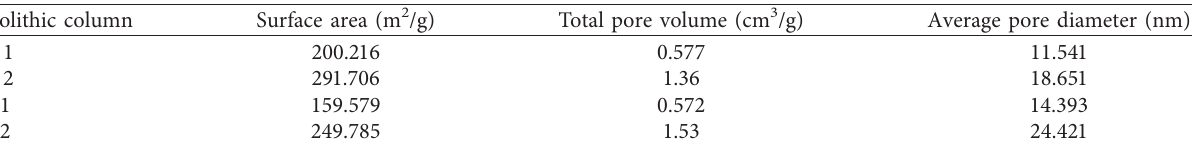
Figure 4: Polymer morphology as seen by SEM of the monolithic column MIP 1 (a); MIP 2 (b); NIP 1 (c); NIP 2 (d). Table 2: Pore structure characteristics of the monolithic columns.